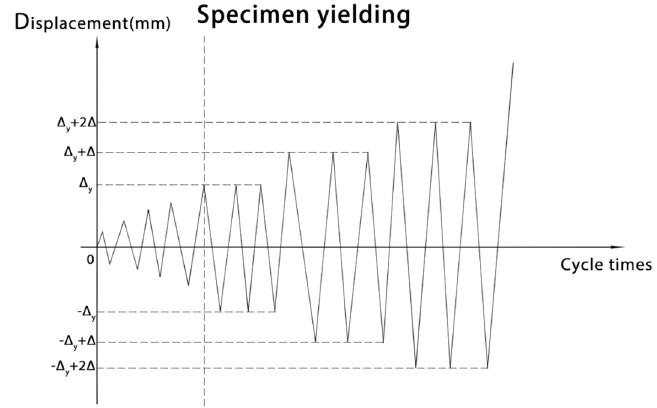
Figure 6. Loading procedure. Figure 6. Loading